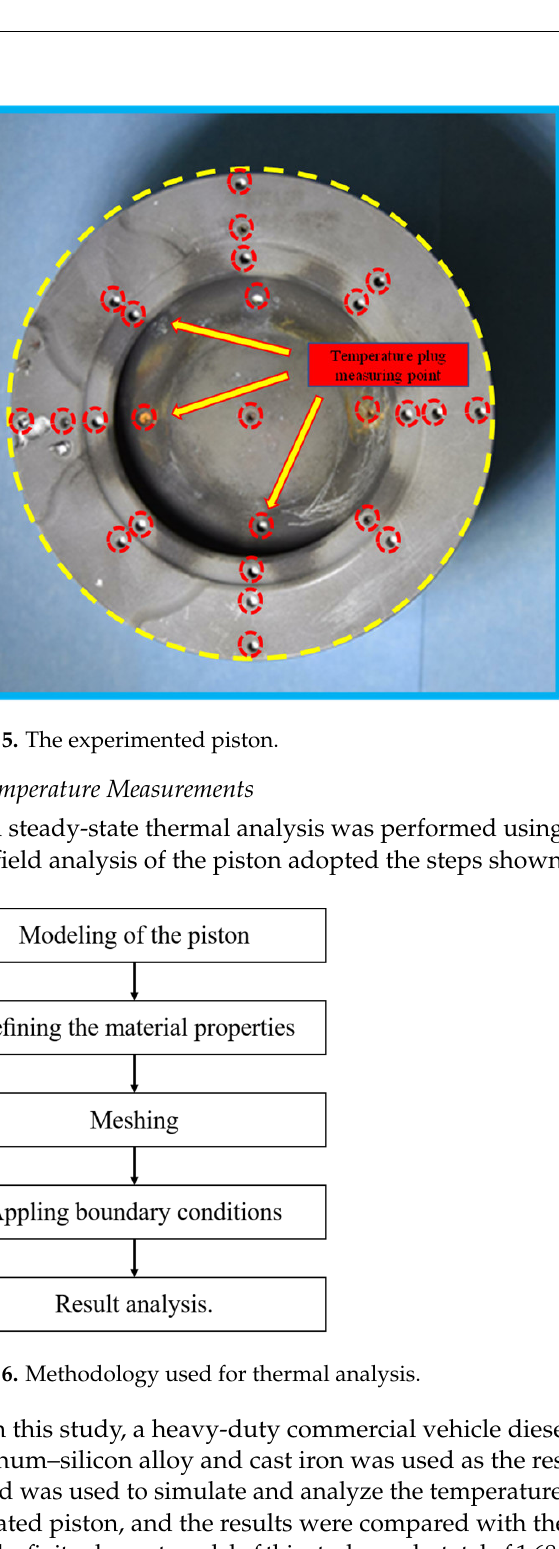
Figure 6. Methodology used for thermal analysis.